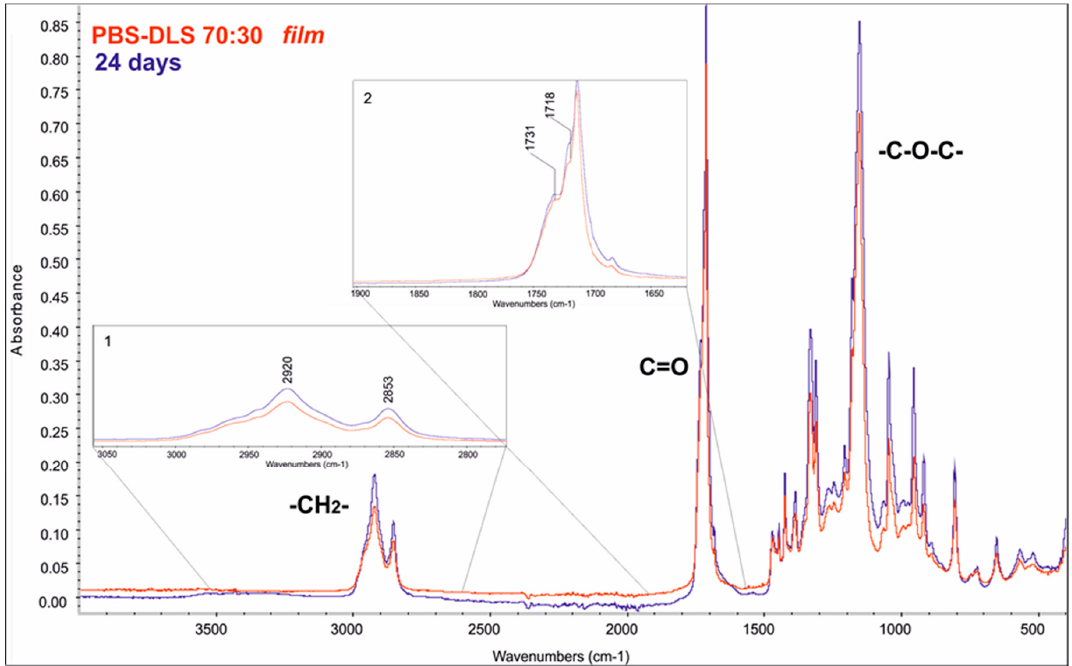
Figure 7. FTIR-ATR spectra of PBS DLS 70:30 films, before and after the enzymatic degradation. Inset (1): 2920, 2853 cm − 1 correspond to aliphatic soft segments backbone. Inset (2): peaks corresponding to ester carbonyl backbone: 1718 and 1731 cm − 1.